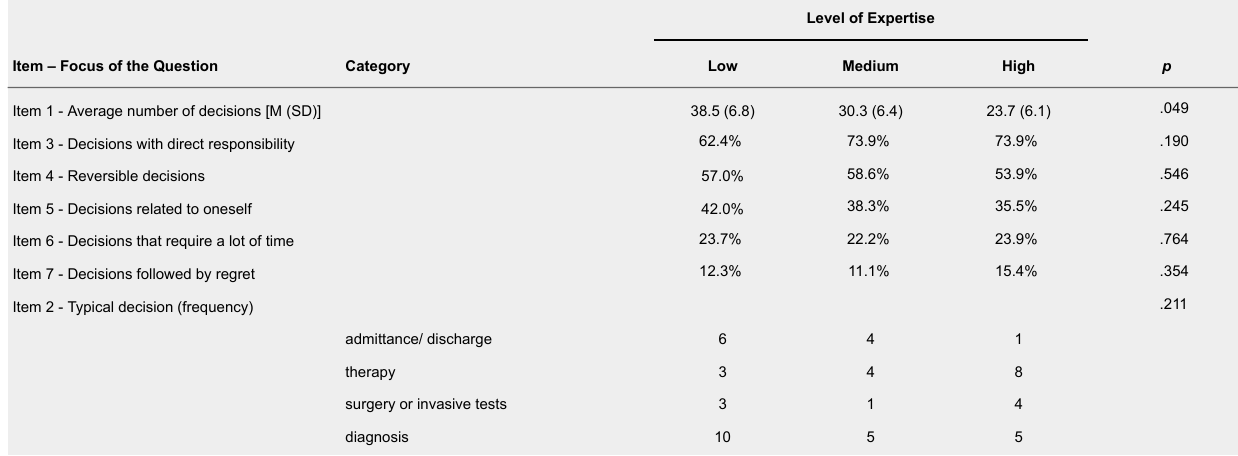
Responses to Questions in the First Part of the Questionnaire, According to Level of Expertise